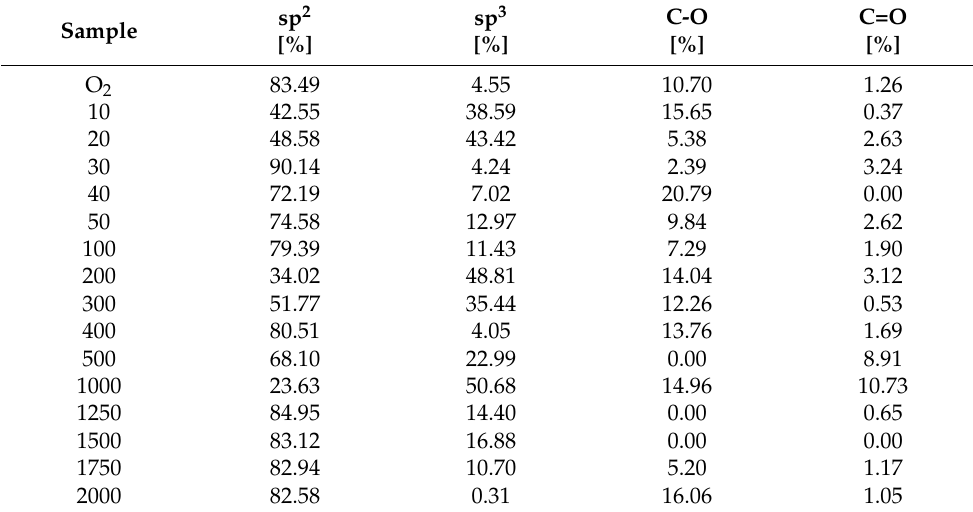
Figure 5. XPS results for thin a-C:H layers on PC. The sp 2 content (black squares) and sp 3 (red circles) bound carbon are plotted against layer thickness (dashed lines show only a trend). Table 2. Results of XPS measurements separated into the percentages of sp 2 , sp 3 , C ‒ O and C=O binding to the C1s peak after deconvolution.